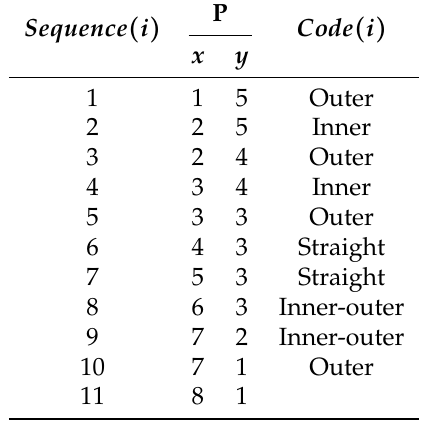
Table 2. Result table of the proposed contour